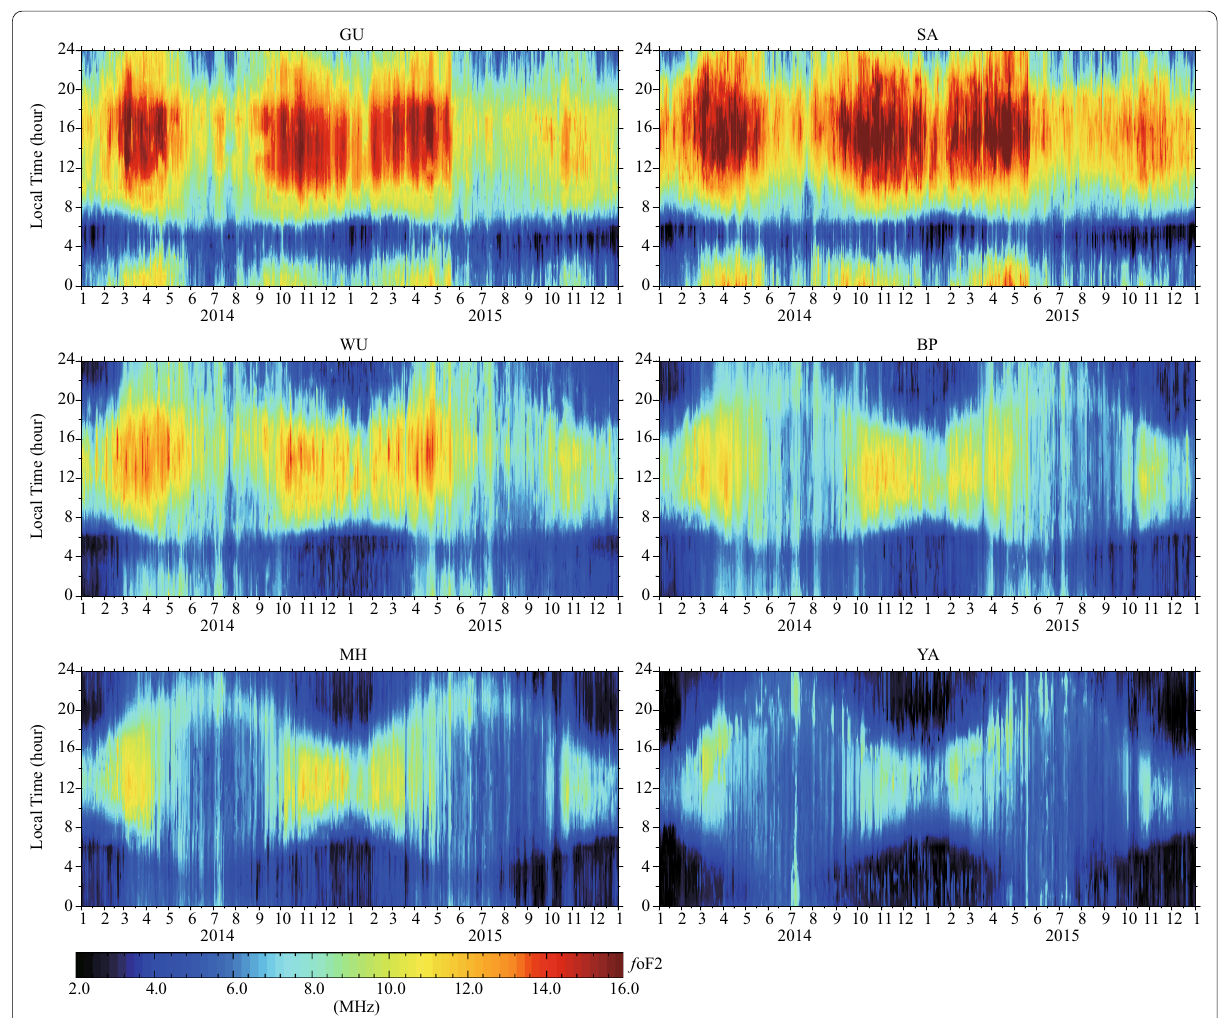
Fig. 3 Time sequences of f oF 2 during 2014–2015 at Guam (GU), Sanya (SA), Wuhan (WU), Beijing (BP), Mohe (MH) and Yakusk